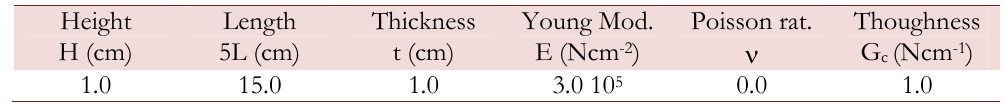
Table1: Geometric and material